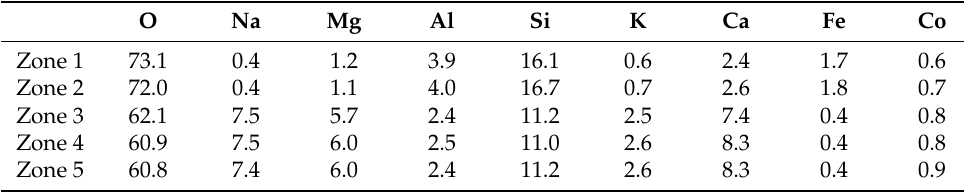
Table 2. EDS results in Figure 5b (at.%).